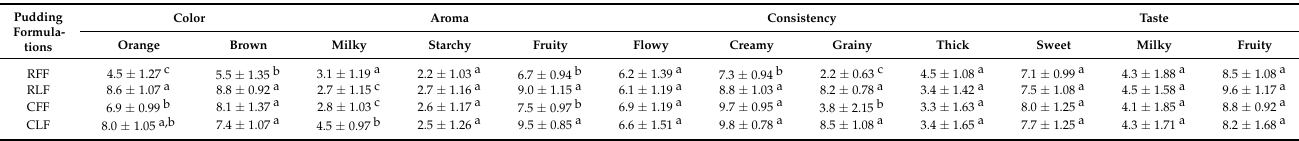
Table 7. Sensory attributes of pudding formulations (RFF—rice starch, peach pur é e; RLF—rice starch, lyophilized